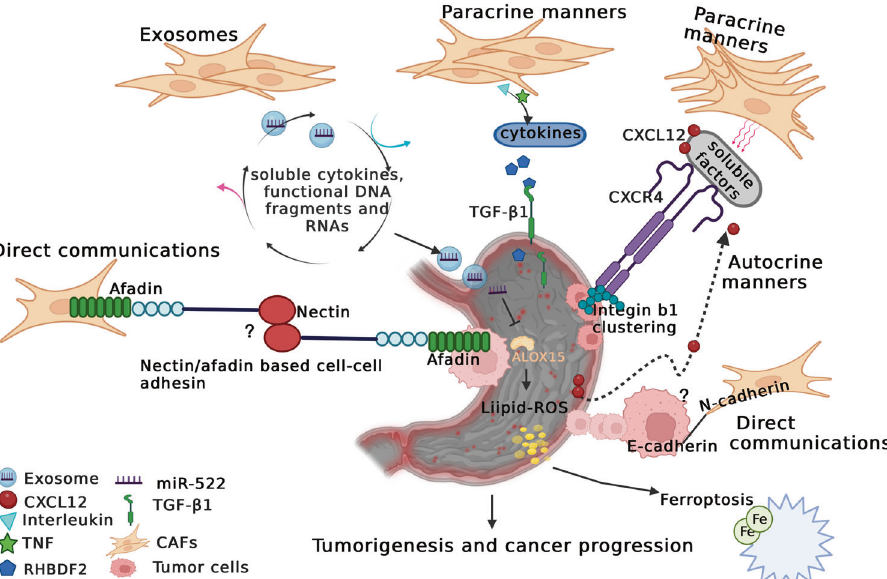
Fig. 3 The mechanism of crosstalk interactions between CAFs and tumor cells. The mechanisms by which tumor cells interact with CAFs remain to be elucidated. CAFs and tumor cells may cooperate to invade via diverse communication behaviors, including the chemoattractant gradient produced by soluble cytokines, different secretory patterns, which including paracrine and autocrine signaling, exosomes, and direct